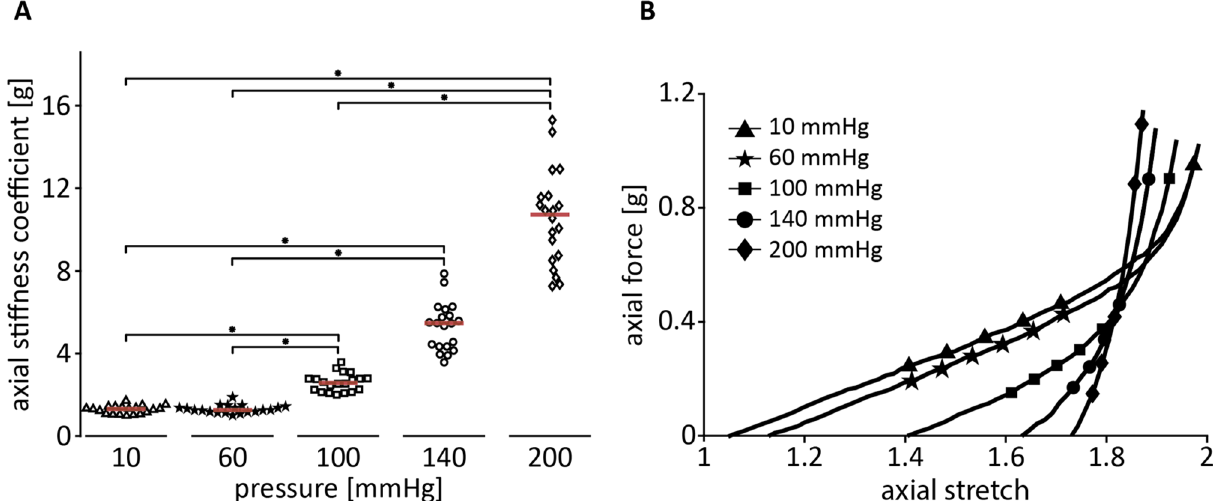
Figure 6. Axial stiffness coefficient increases with increasing pressure. ( A ) Axial stiffness coefficient was determined as the local derivative at (cid:31) z = (cid:31) z , iv (mean crossing points of force-stretch curves ( B )). Asterisks indicate statistically significant differences between groups. * p < 0.05, n = 20. ( B ) Representative quasi-static force-stretch relation under different static pressures.